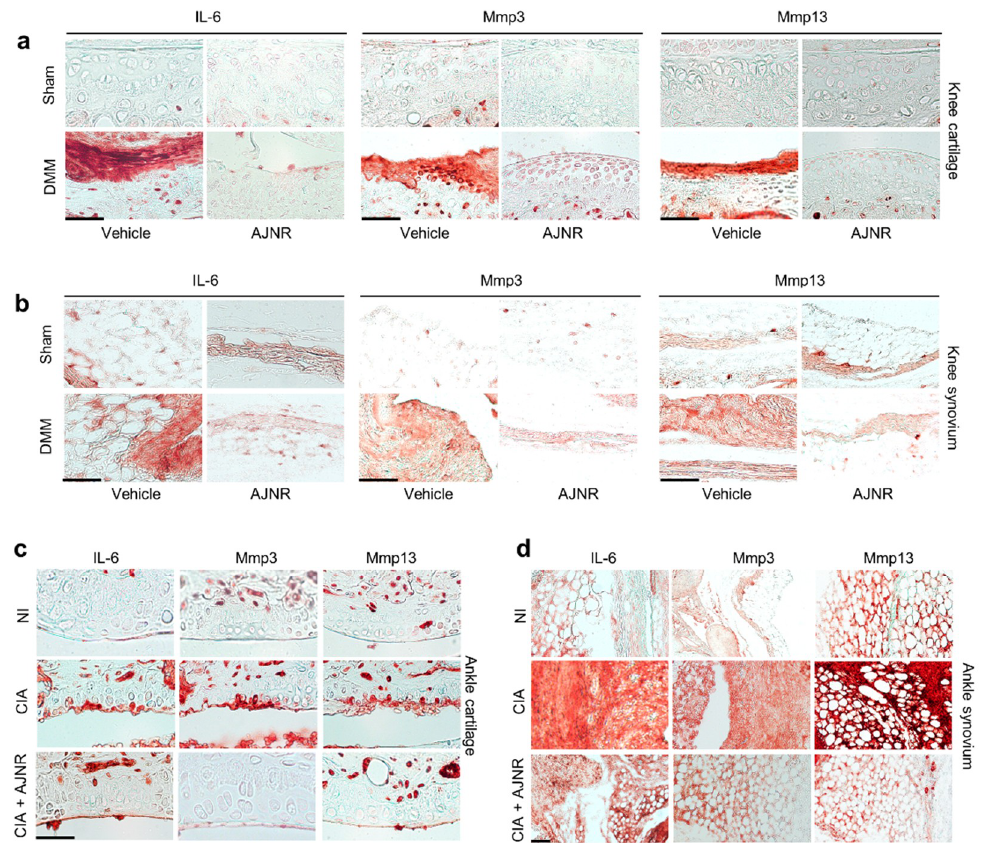
Figure 7. ( a , b ) AJNR inhibits IL-6-mediated Mmp3 and Mmp13 expression in destabilization of the medial meniscus (DMM) surgery-induced osteoarthritis. First, 12-week-old C57BL/6 male mice were subjected to a sham operation or DMM surgery. Sham- or DMM-operated mice were intraperitoneally injected with AJNR (2 mg/kg) (2 times per week for 8 weeks). ( a ) Representative images of IL-6, Mmp3, and Mmp13 immunostaining in the knee cartilage tissue sections of sham, DMM, and AJNR-treated DMM mice ( n = 4 mice per group). ( b ) Representative images of IL-6, Mmp3, and Mmp13 immunostaining in the synovial tissue sections of sham, DMM, and AJNR-treated DMM mice ( n = 4 mice per group). ( c , d ) AJNR inhibits IL-6-mediated Mmp3 and Mmp13 expression in CIA-induced rheumatoid arthritis. CIA models were established using 7-week-old DBA/1J male mice. During arthritis induction, AJNR intraperitoneal injections were administered (2 times per week for 6 weeks). ( c ) Representative IL-6, Mmp3, and Mmp13 immunostaining in the ankle cartilage tissue sections of non-immunized (NI), CIA, and AJNR-treated CIA mice ( n = 4 mice per group). ( d ) Representative images of IL-6, Mmp3, and Mmp13 immunostaining in the synovial tissue sections of NI, CIA, and AJNR-treated CIA mice ( n = 4 mice per group). The results are representative of three independent experiments. Scale bar: 50 µ